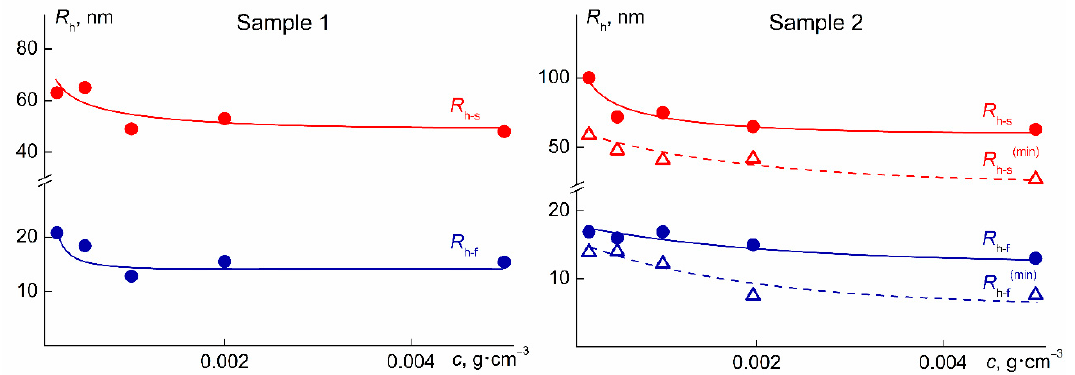
Figure 5. The dependences of the hydrodynamic radius R h of scattering species on concentration c for aqueous solutions of investigated molecular brushes at 21 °C.